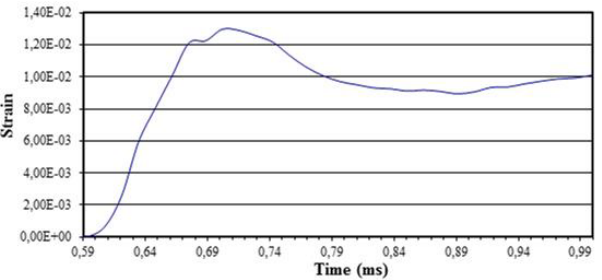
Figure 9. Strain-time curve in the centre of the SiC-reinforced ZC71 magnesium alloy specimen for modified SHTB (Model 3) when using 1mm thick lead damping rings at − 5000mms − 1